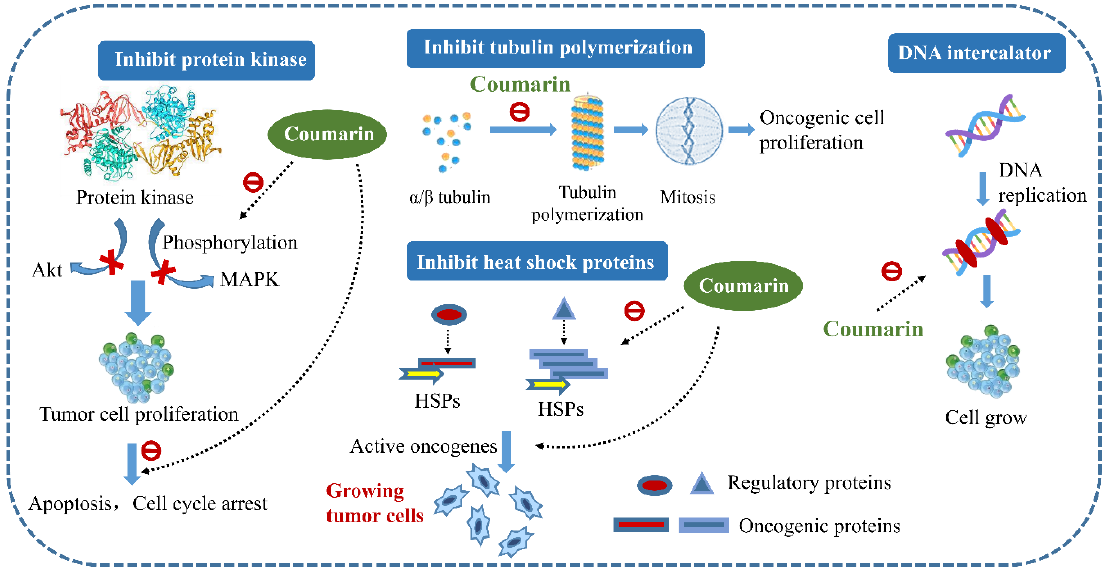
Figure 11. The antitumor mechanism of coumarin.